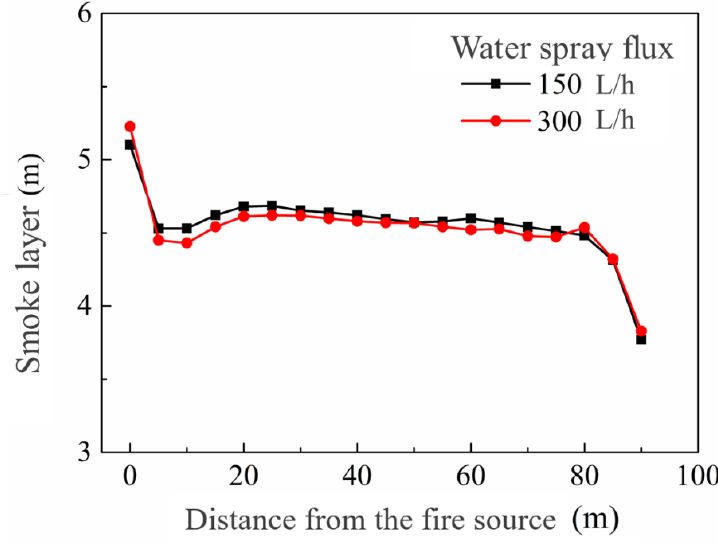
Figure 14. Height of smoke layer in tunnel.